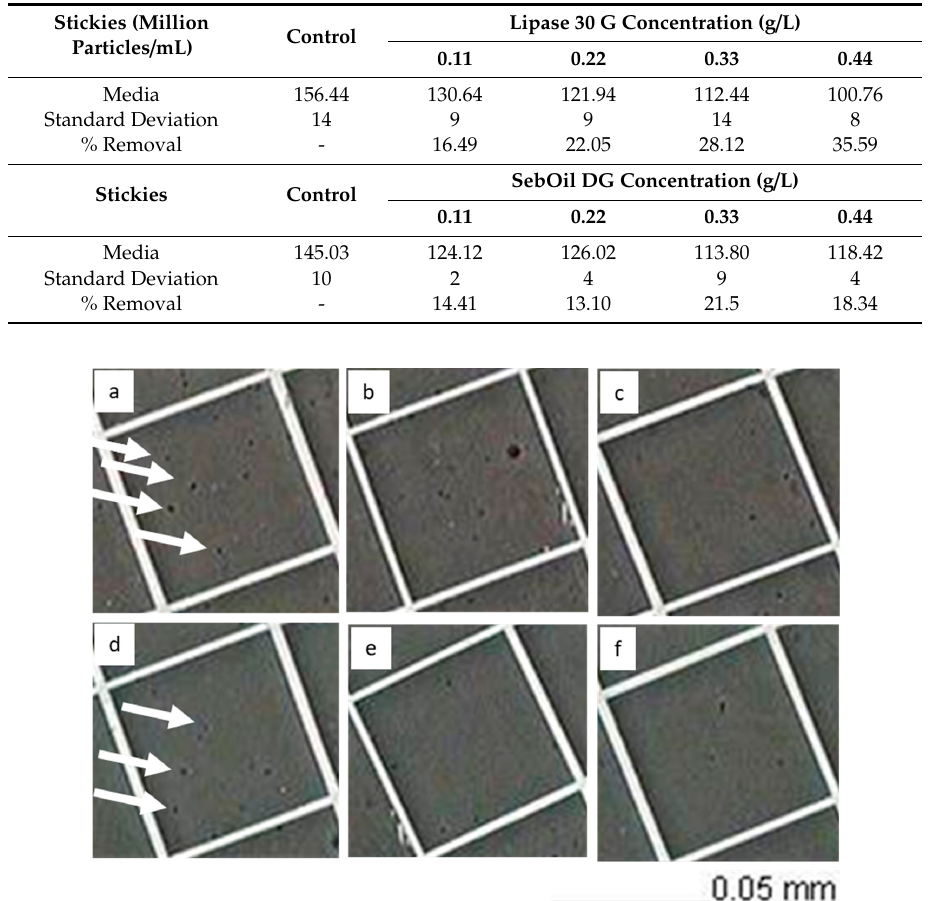
Figure 5. E ff ect of enzyme Lipase 30 G at di ff erent concentrations on the stickies. ( a , b ) control; Figure 5. Effect of enzyme Lipase 30 G at different concentrations on the stickies. ( a , b ) control; ( c ) 0.11 ( c ) 0.11 g / L; ( d ) 0.22 g / L; ( e ) 0.33 g / L; and ( f ) 0.44 g / L. Large stikies are denoted by an g/L; ( d ) 0.22 g/L; ( e ) 0.33 g/L; and ( f ) 0.44 g/L. Large stikies are denoted by an arrow.